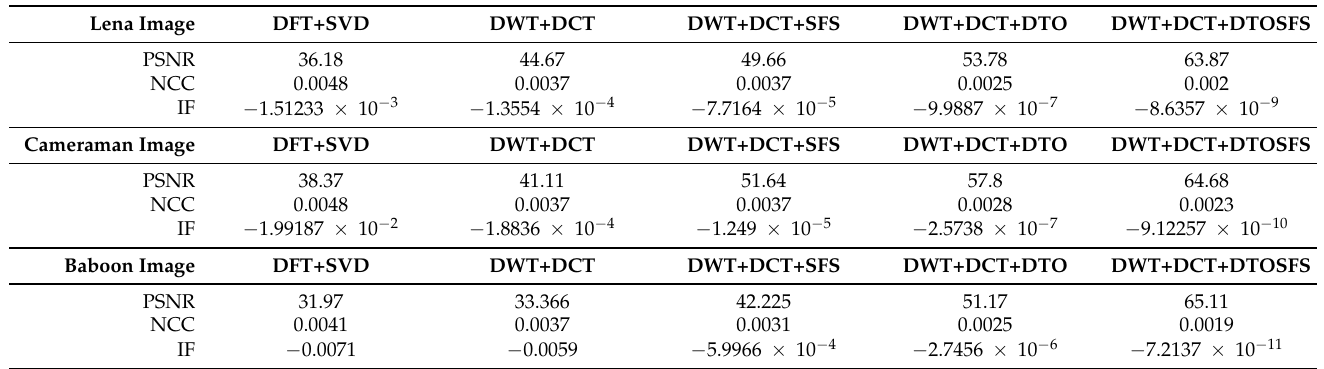
Table 1. Assessment of the results achieved by the proposed approach in comparison with those of the other competing